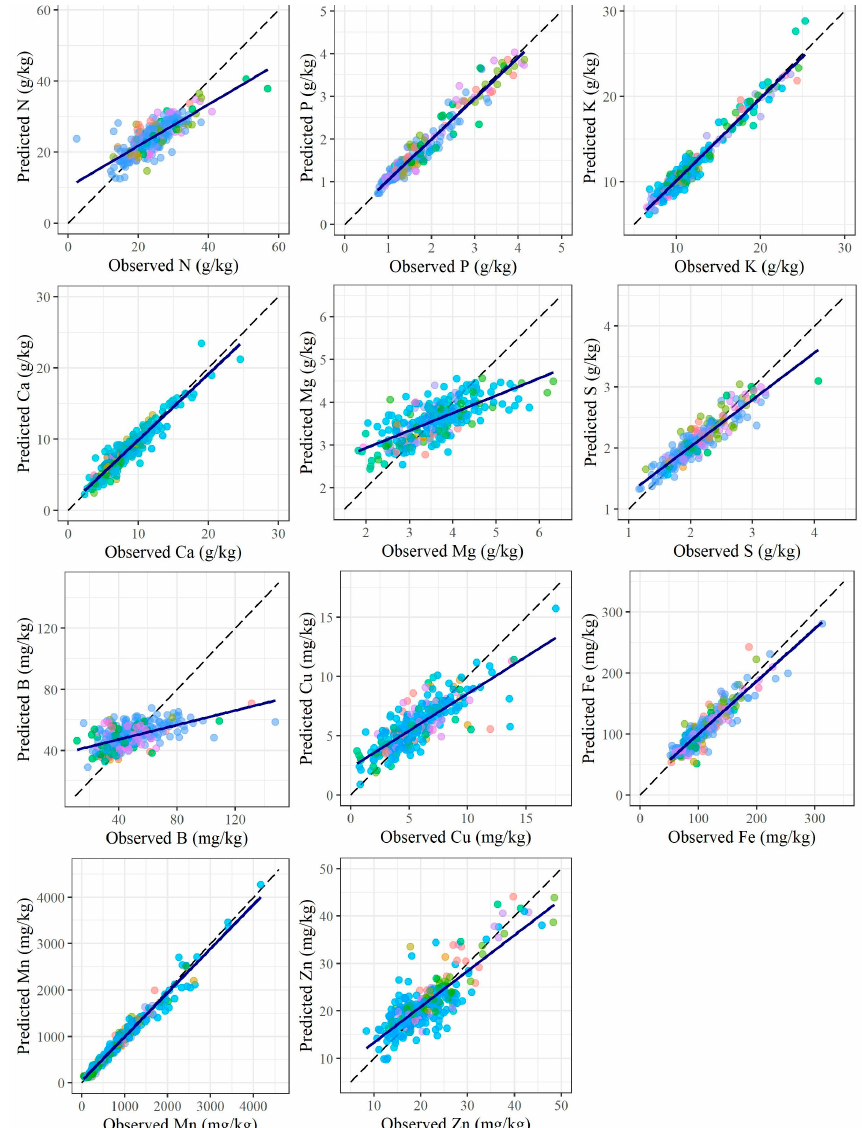
Figure 2. Observed versus predicted scatter plots for the best macro and micronutrients prediction models of Eucalyptus spp. leaves based on portable X-ray fluorescence (pXRF) elemental data. Table 3. Root mean square error (RMSE), coefficient of determination (R 2 ), and residual prediction deviation (RPD) for macro and micronutrients prediction models of Eucalyptus spp. leaves based on portable X-ray fluorescence (pXRF) elemental data.